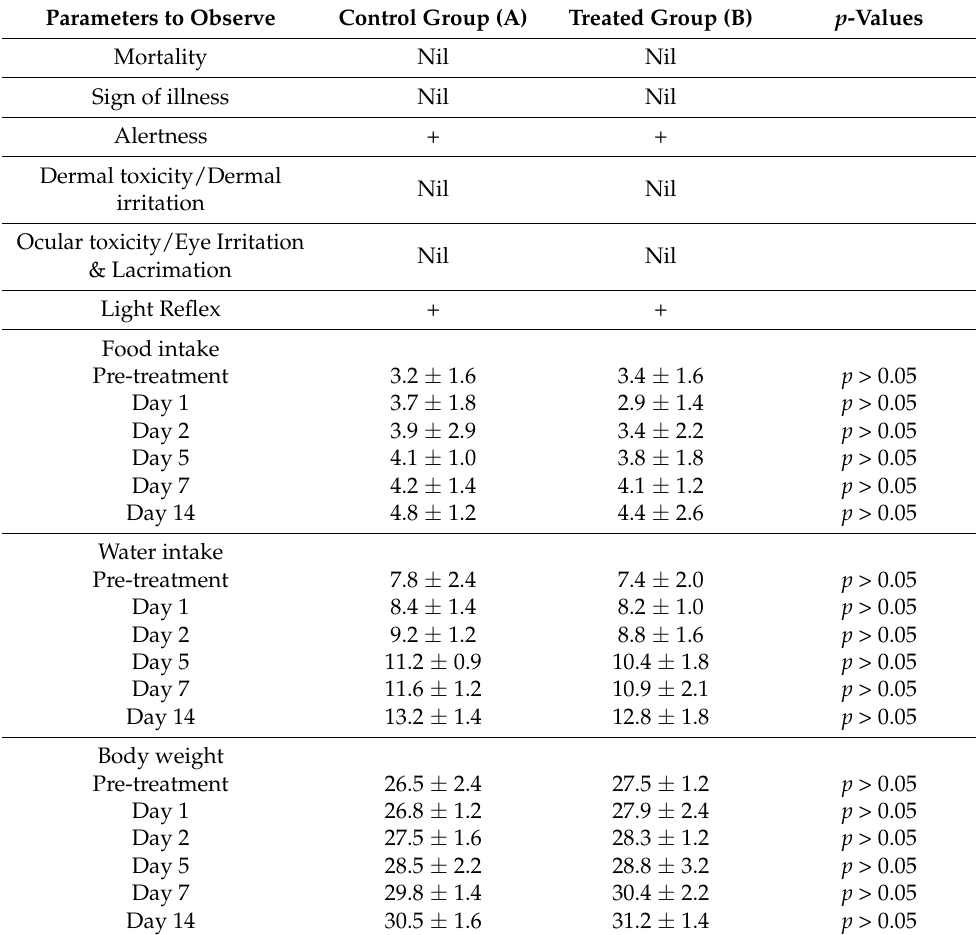
Table 3. Observations of different parameters (sign of illness, mortality, food intake, water intake and body weight) of control and hydrogel-treated